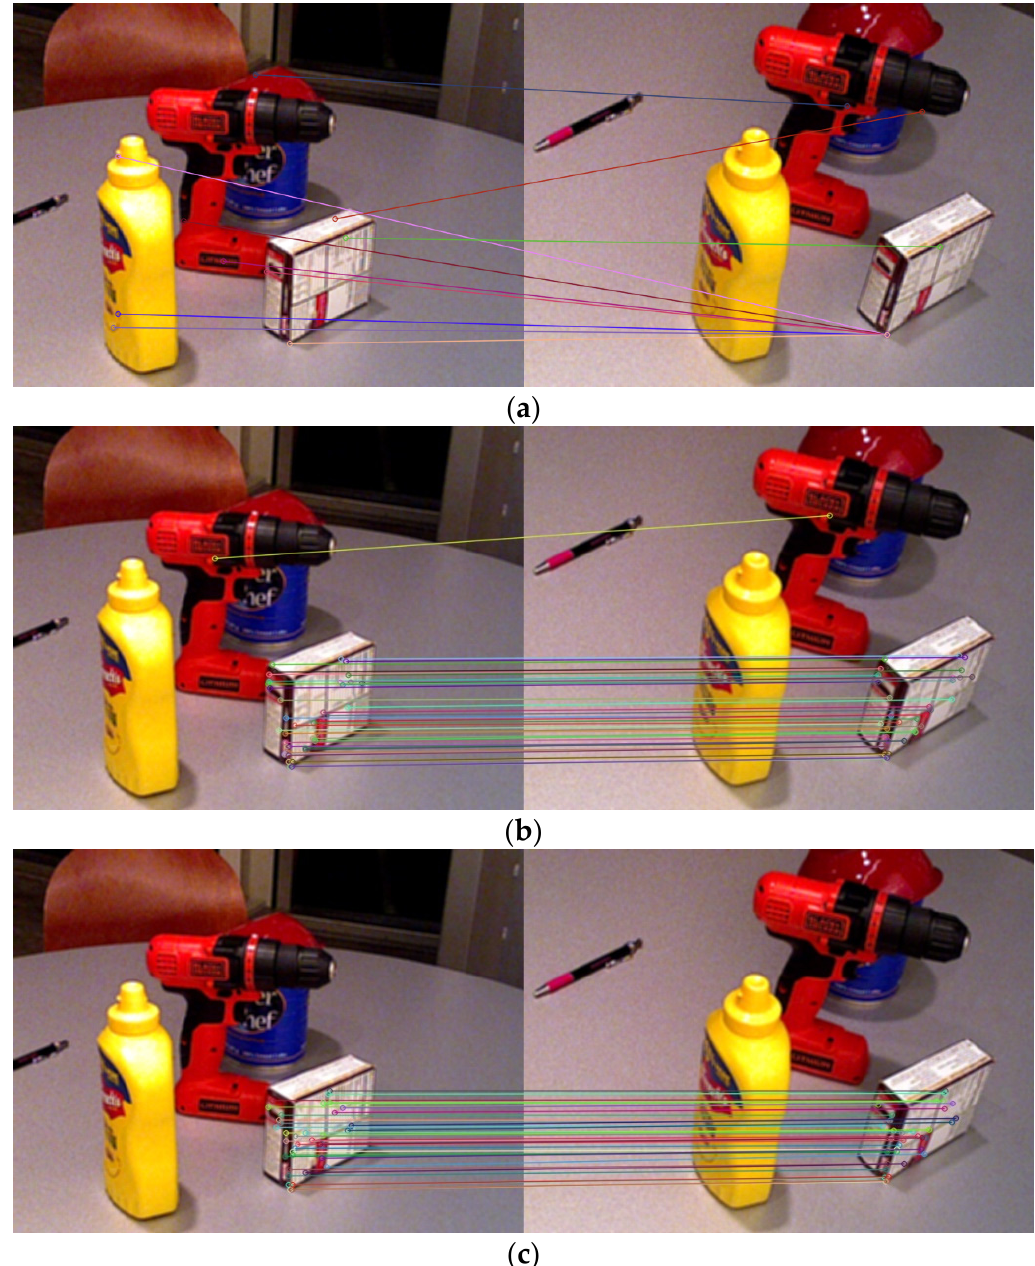
Figure 14. Example of successful registration of ORBPFH and ORBFPFH but failed registration of ORB. ( a ) ORB registration of frames 1 and 227 in the YCB 0024 dataset. ( b ) ORBPFH registration of frames 1 and 227 in the YCB 0024 dataset. ( c ) ORBFPFH registration of frames 1 and 227 in the YCB 0024 dataset.